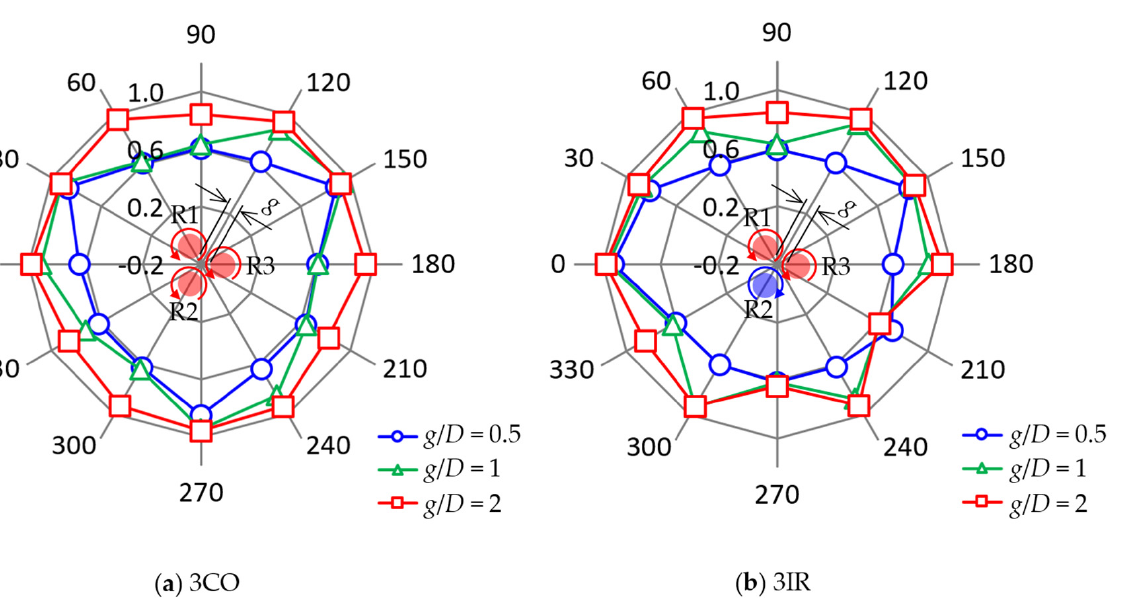
Figure 19. Comparison between the experimental and CFD results on 12 ‐ wind ‐ direction depend ‐ ence of normalized rotational speed in a trio of VAWT models at g / D = 1 in the 3CO configuration: ( a ) Rotor 1; ( b ) Rotor 2; ( c ) Rotor 3; ( d ) Average.